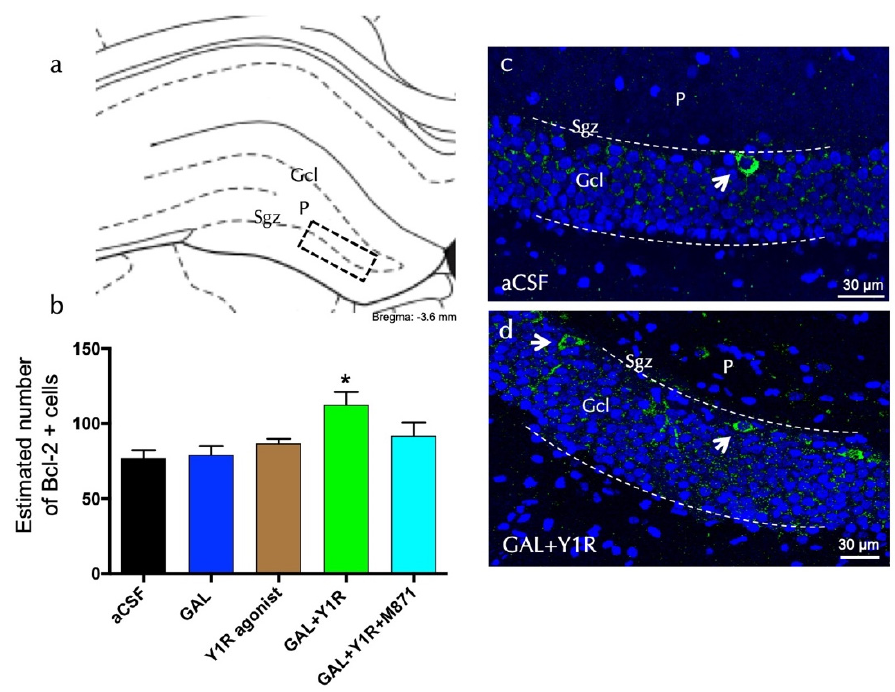
Figure 3. Dentate gyrus (DG) hippocampal anti-apoptotic Bcl-2-immunoreactive cells (Bcl-2-IR) after galanin and the Y1R agonist co-administration. ( a ) Bcl-2-IR cells were located in the sub-granular zone (Sgz) of the dentate gyrus at the border between the granular cell layer (Gcl) and the polymorphic layer (P) of the dentate gyrus in the dorsal hippocampus (Bregma: − 3.6 mm, according to the Paxinos and Watson [33] stereotaxic atlas). ( b ) Quantitative morphometric analysis of Bcl-2-IR cells of the DG. GAL and Y1R agonist icv co-administration significantly increased Bcl-2-IR cells in the dorsal DG. This effect was blocked by treatment with the GALR2 antagonist M871. * p < 0.05 vs. the rest of the groups according to one-way ANOVA followed by Newman–Keuls post-hoc test. Data are expressed as mean ± SEM, n = 4. Statistical values are presented in Supplementary Table S1. ( c,d ) Representative microphotographs of the significant increase in the Bcl-2-positive cells in the DG after GAL and Y1R agonist co-injection ( d ) compared with the control group ( c ). The cells in green are BDNF-positive using confocal laser microscopy. White arrows point to Bcl-2-IR cells. Dashed lines outline the Gcl of the dentate gyrus. The nuclei are shown in blue by DAPI. Abbreviations: aCSF = Control (artificial cerebrospinal fluid), GAL = galanin (3 nmol), Y1R agonist = Y1R receptor agonist [Leu 31 -Pro 34 ]NPY (3 nmol), GAL + Y1R = co-administration of GAL and Y1R, GAL + Y1R + M871 = co-administration of GAL, Y1R, and GALR2 antagonist M871 (3 nmol). 3.3. GALR2 Agonist and Y1R Agonist Interaction Enhanced Survival and Neurite Outgrowth on Hippocampal Neuronal Cells To detect overall neuronal viability modulating effects, the effects of the GALR2 ag- onist M1145 and/or the Y1R agonist were monitored in an MTS cell proliferation assay after incubating cells with each substance in a time-course manner. The results of these experiments are summarized in Figure 4a. Upon incubation with M1145 and the Y1R ag- onist, hippocampal neurons’ viability was stable and resulted in an increased rate of sur- vival at 24 h, as compared with the control (t = 2.535, df = 14; p < 0.05), M1145 (t = 2.765, df = 14; p < 0.05), and Y1R agonist (t = 2.649, df = 14; p < 0.05) groups (Figure 4a). Moreover, the specific GALR2 antagonist M871 abolished this effect (t = 2.755, df = 14; p < 0.05) (Figure 4b), demonstrating that this effect was mediated through the coactivation of GALR2 and NPYY1R. Statistical values are presented in Supplementary Table S1. However, incuba- tion with M1145 or the Y1 agonist alone revealed a minor influence on neuronal viability compared to the control. These results indicate that the co-incubation of the GALR2 ago- nist and the Y1R agonist in solution exerts a profound effect on the survival of neurons.